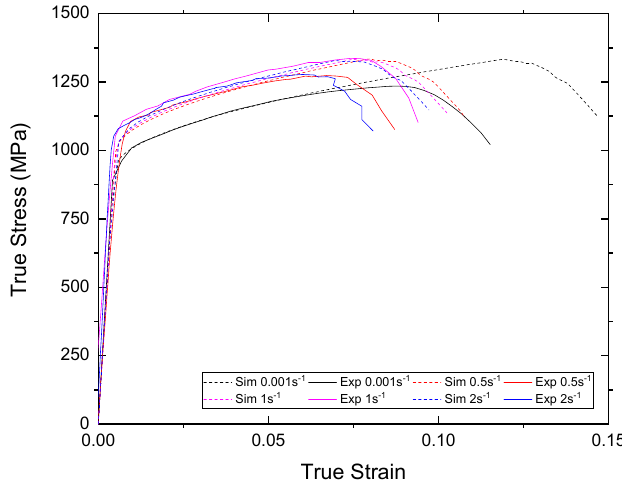
Figure A3. Comparison between experimental (Exp, continuous lines) and FE simulation (Sim, dotted lines) results for 0.001 s − 1 –2s − 1 strain rates using JC damage parameters of Table A1.